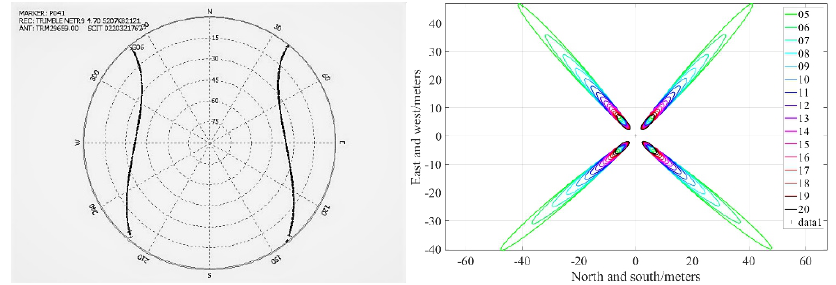
Fig.2 PRN06 satellite running track map and Fresnel reflection